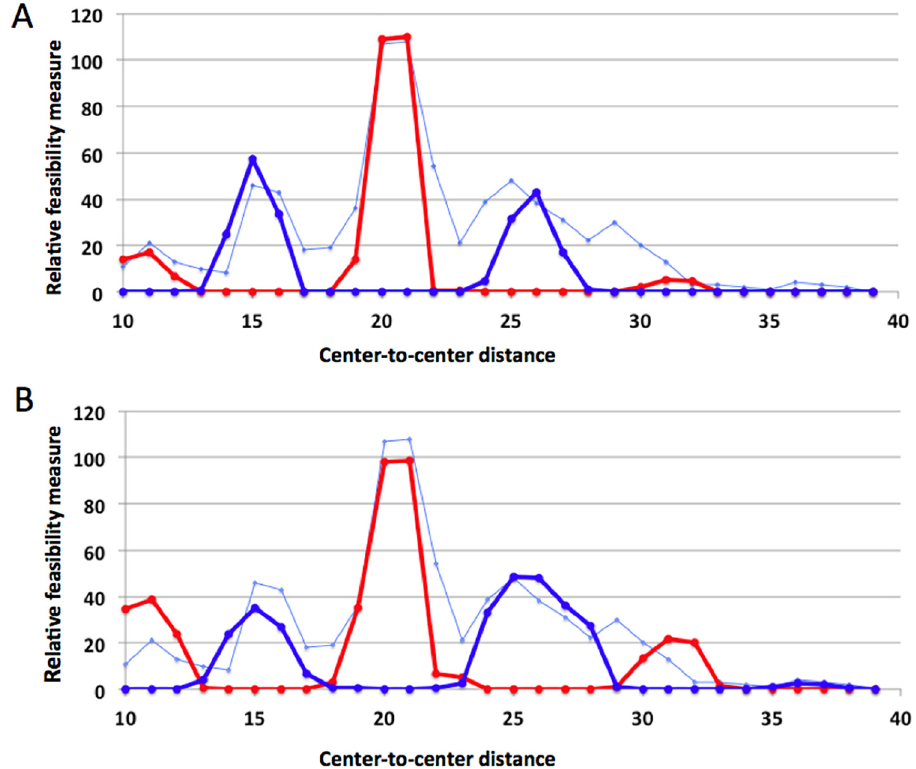
Fig 5. Computed scaled feasibility measures of the tetramer formation vs. CTCD using two NDDs ( A ) or at least one NDD ( B ). The red and blue points are for the ‘ eclipsed ’ and the ‘ staggered ’ tetramers, respectively, with the NDD off- and on-axis, respectively. The red and blue points were scaled so as to put them on the same scale as the experimental counts (shown in thin blue line) of tetramer binding sites in the mouse genome. For this figure, we used the DNA with 10.5 bps per helical turn. The results using the 10.0 bp DNA are given in Fig